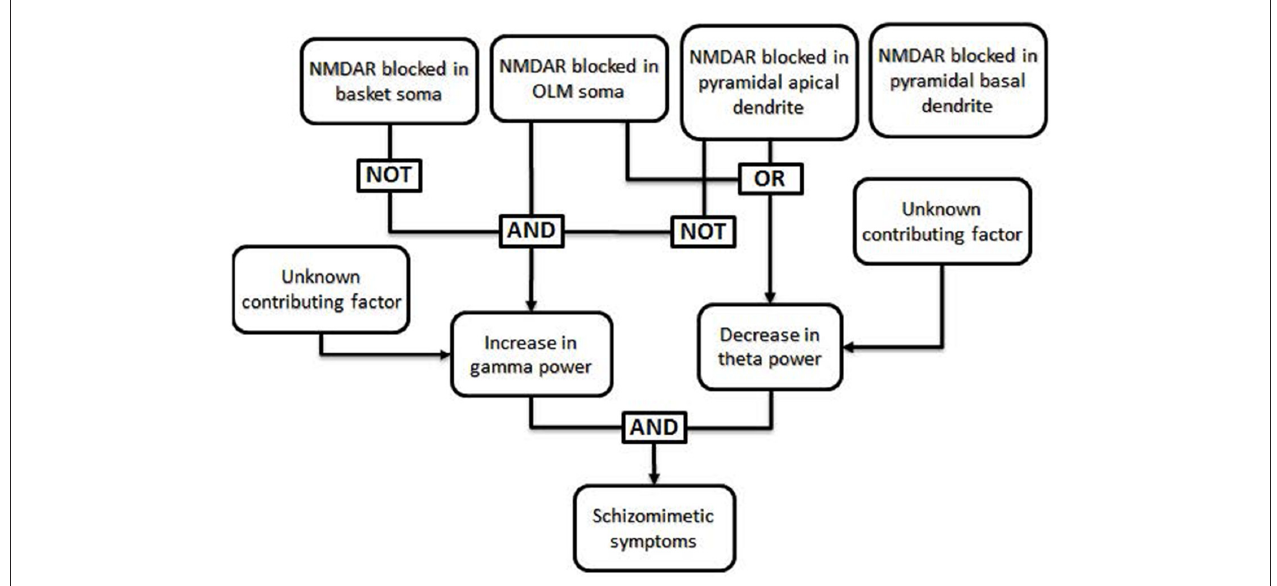
FIGURE 2 | Specific example of a fault tree generated from results of Neymotin et al. (2011) . The authors used a computational model to investigate the conditions under which the power of theta frequency oscillations (3–12 Hz) decrease while the power of gamma frequency oscillations (30–100 Hz) increase, as seen in animals and human patients after ketamine administration (Ehrlichman et al., 2009; Hong et al., 2010; Lazarewicz et al., 2010). In their computational model, a decrease in theta power resulted when NMDA receptors (NMDARs) were blocked in either the somas of oriens-lacunosum moleculare (OLM) cells or in the apical dendrites of pyramidal cells, regardless of the function of NMDARs in other cell types. In the same model, an increase in gamma power occurred only when NMDARs were blocked in the somas of OLM cells and NMDARs were not blocked in basket cells or the apical dendrites of pyramidal cells. Thus, the only combinations which generated both an increase in gamma power and a decrease in theta power involved blocking NMDARs in OLM soma with intact NMDARs in basket cells and pyramidal apical dendrites; the state of NMDARs in the pyramidal basal dendrites did not affect these results and can thus be said to be irrelevant in this case. Generation of a fault tree from these results allows one to visualize the roles that each factor plays in multiple downstream effects. Additional, unknown, factors may also impact the